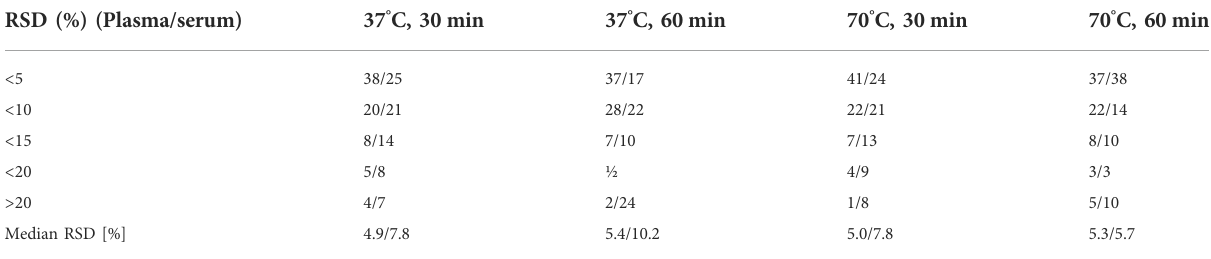
TABLE 5 Comparison of different SIL conditions based on the repeatability of 75 MDMs detected in both types of samples, in the table was presented number of MDMs with RSD for plasma/serum ≤ 10% – 30% and above 30%. RSD (%)